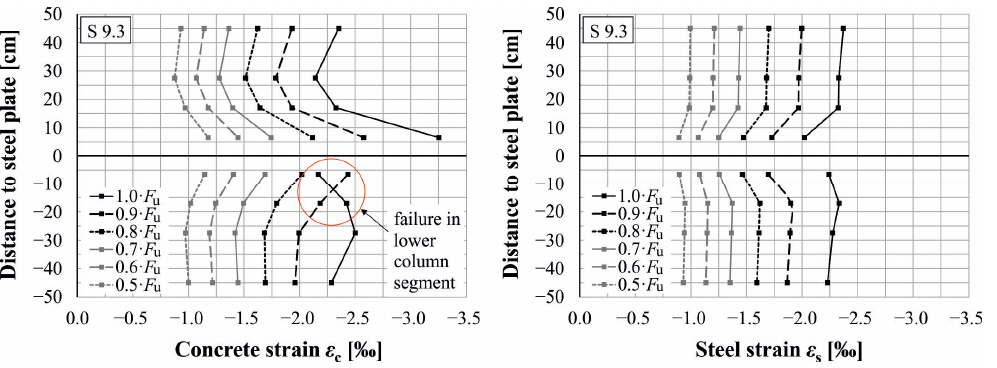
Figure 12. Measured concrete ( left ) and steel stains ( right ) above and below the butt joint for S 9.2.